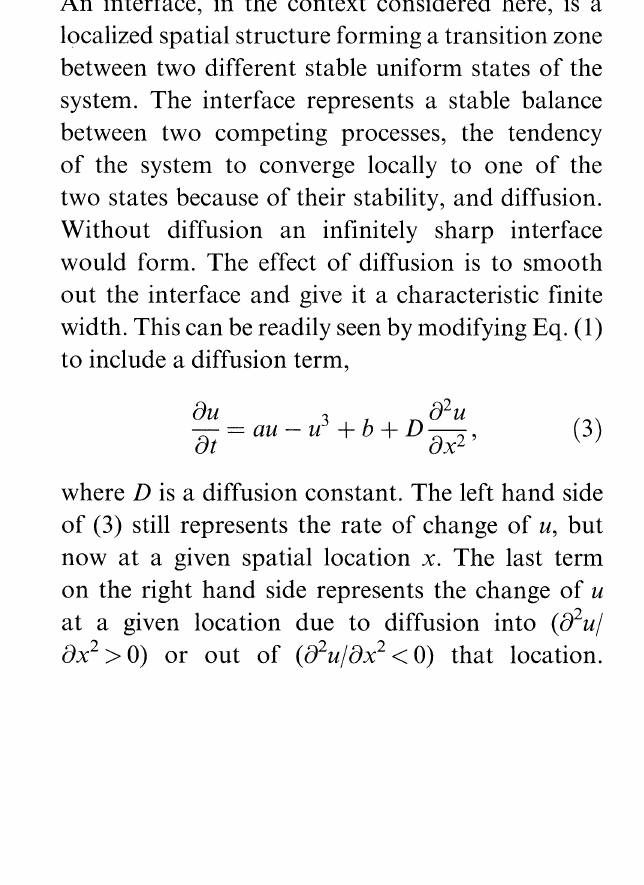
FIGURE 4 The stationary front solution (4) for a= and